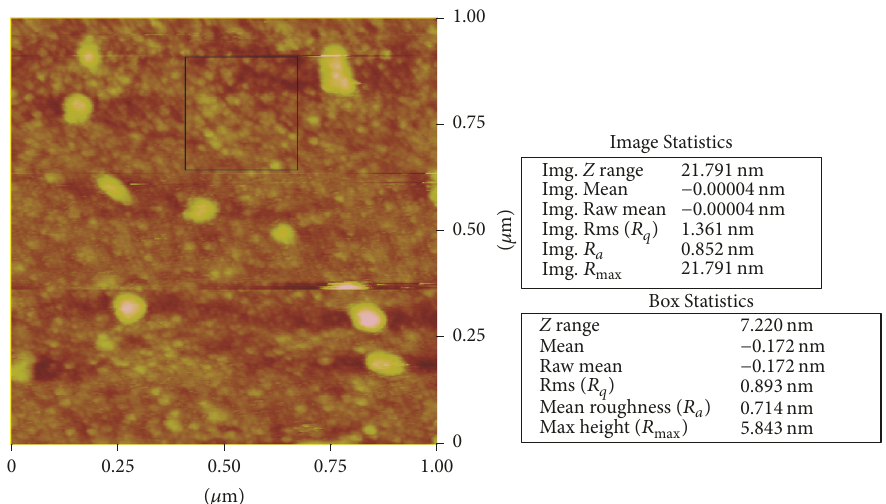
Figure 4: Roughness analysis of the sample heated for one hour at 100 ∘